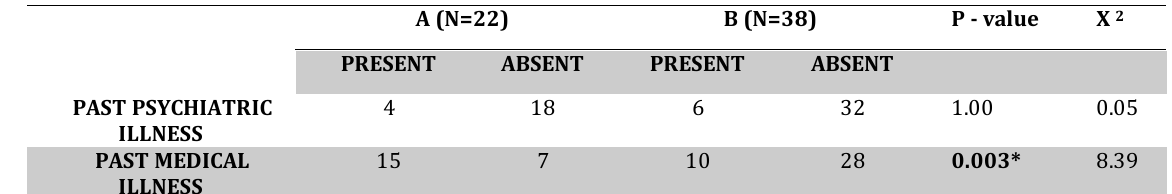
*represents statistical significance. ‘A’ represents patients with psychiatric side effects following Oseltamivir intake. ‘B’ represents patients without psychiatric side effects following Oseltamivir intake.